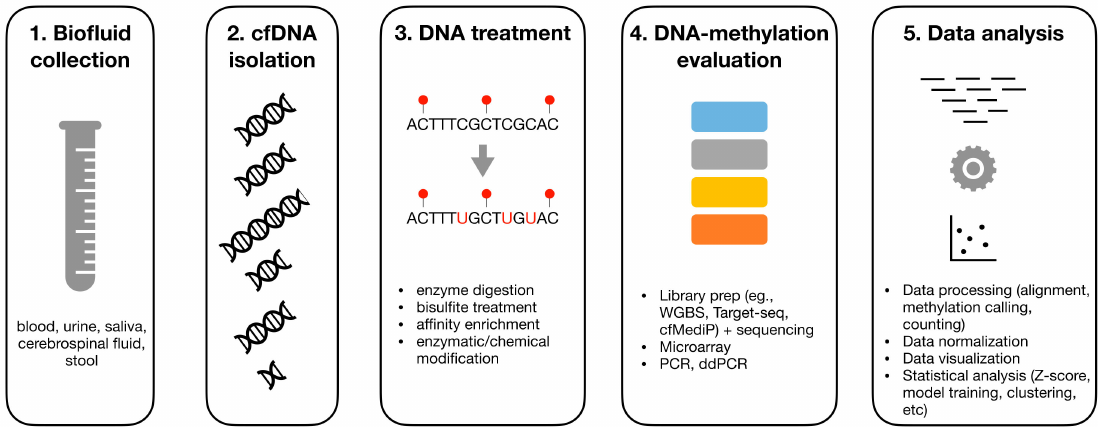
Figure 1. Schematic representation of a typical DNA-methylation analysis workflow from cell-free DNA samples including pre-analytics (biofluid collection and cfDNA isolation), DNA treatment, DNA-methylation evaluation, and computational data